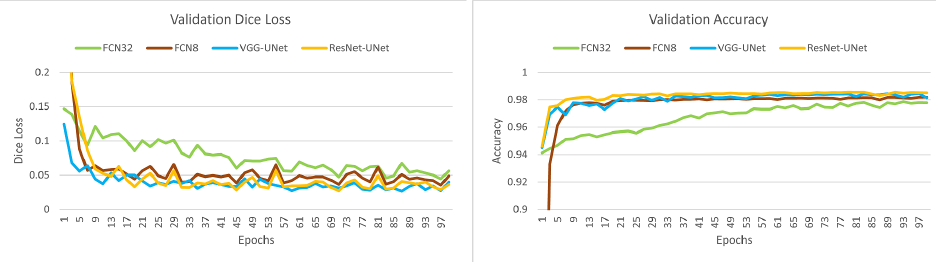
Figure 16. Loss and accuracy of FCN32, FCN8, VGG–UNet and ResNet–UNet networks in validation. Table 2. Accuracy of networks FCN32, FCN8 and VGG–UNet in training and validation.